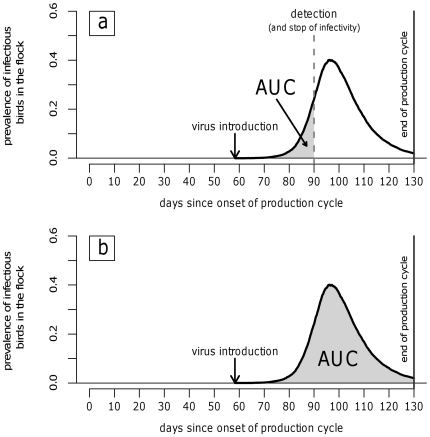
Area under the prevalence curve (AUC, shaded area).(a) AUC assuming that the infectivity is efficiently stopped at day of outbreak detection. (b) AUC in the whole infectious period.